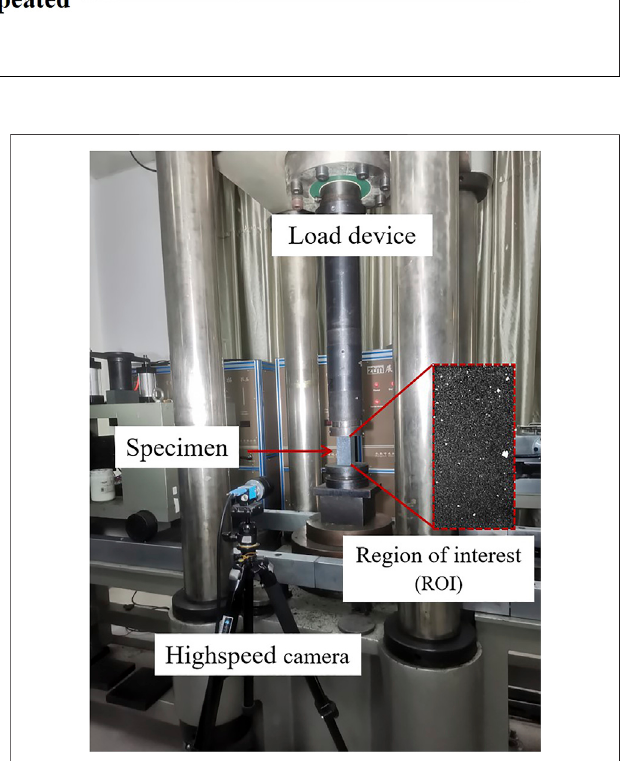
FIGURE 4 | Experimental setup of